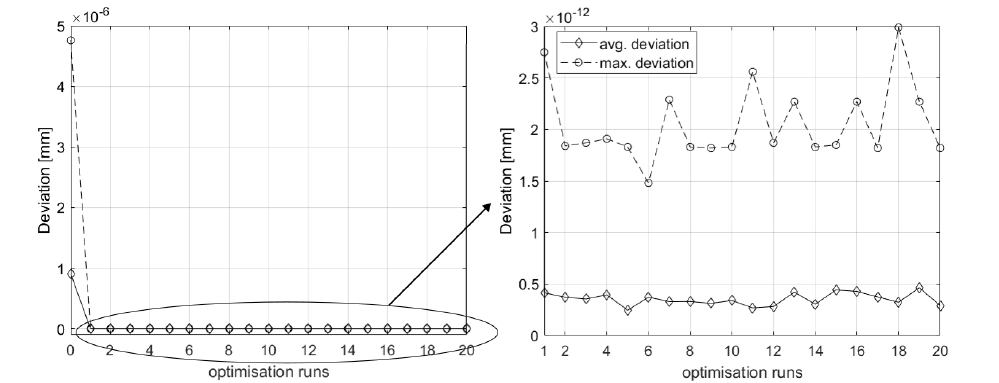
Figure 9. Deviation of surface mesh from CAD during